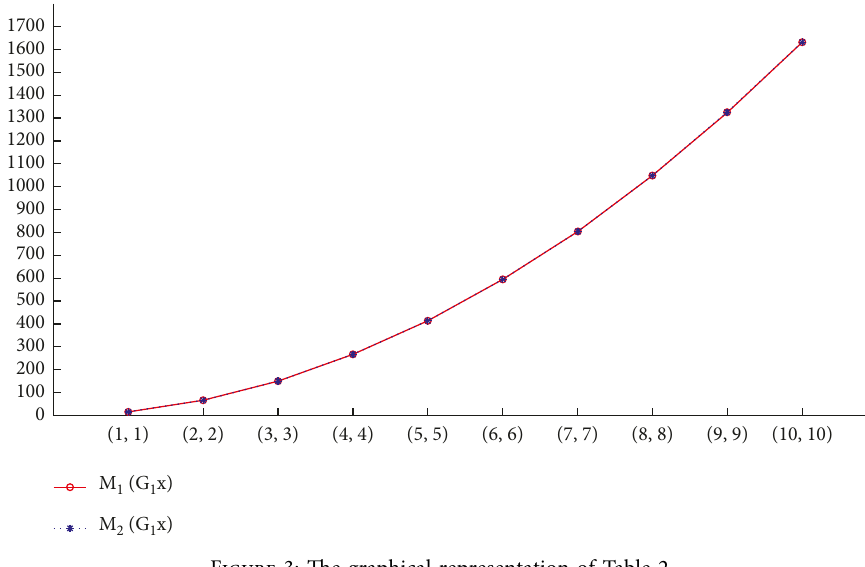
Figure 3: The graphical representation of Table